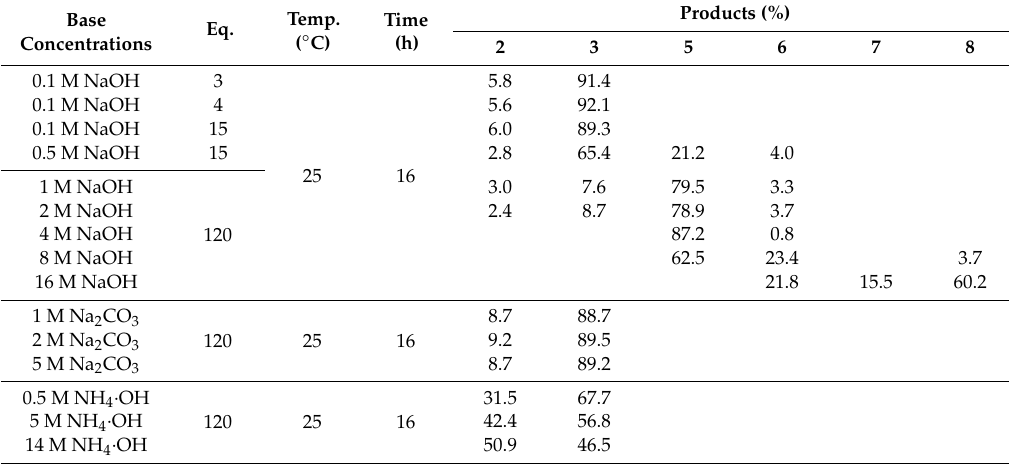
Table 1. The products and yields (%) obtained under various base